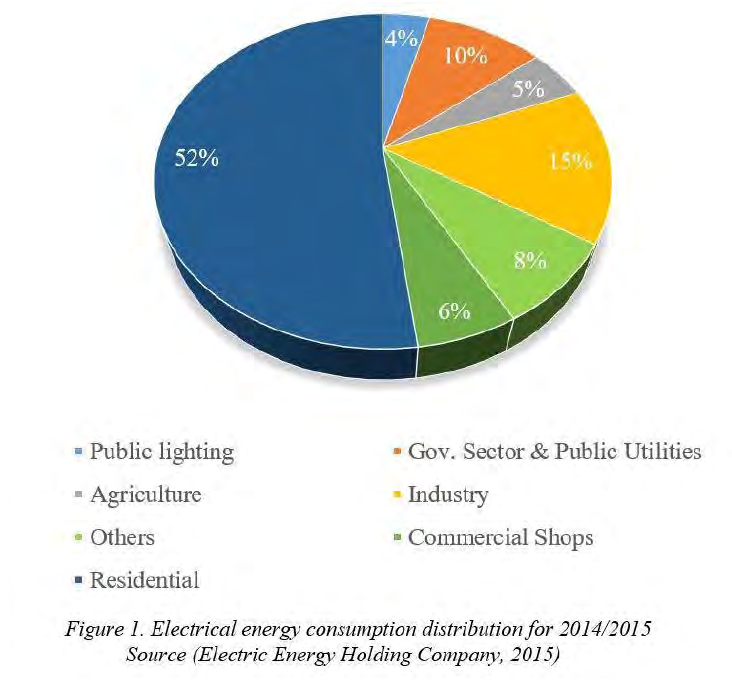
Figure 1. Electrical energy cosumption distribution in Egypt for 2014/2015 (Elec. Energy HoldingCo.,